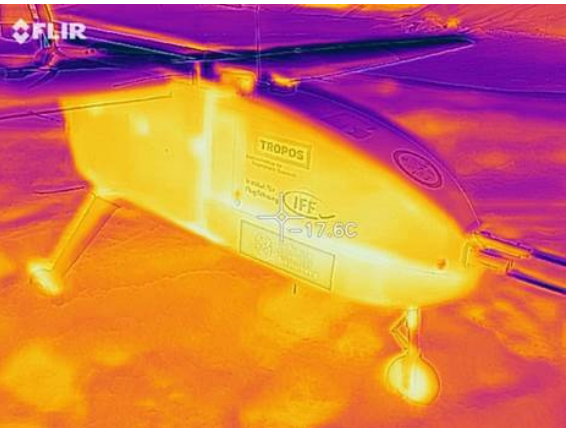
Figure 4. Thermal infrared image of ALADINA. The thermal bridges are visible at the intersections of different compartments and were responsible for losses of heat during the